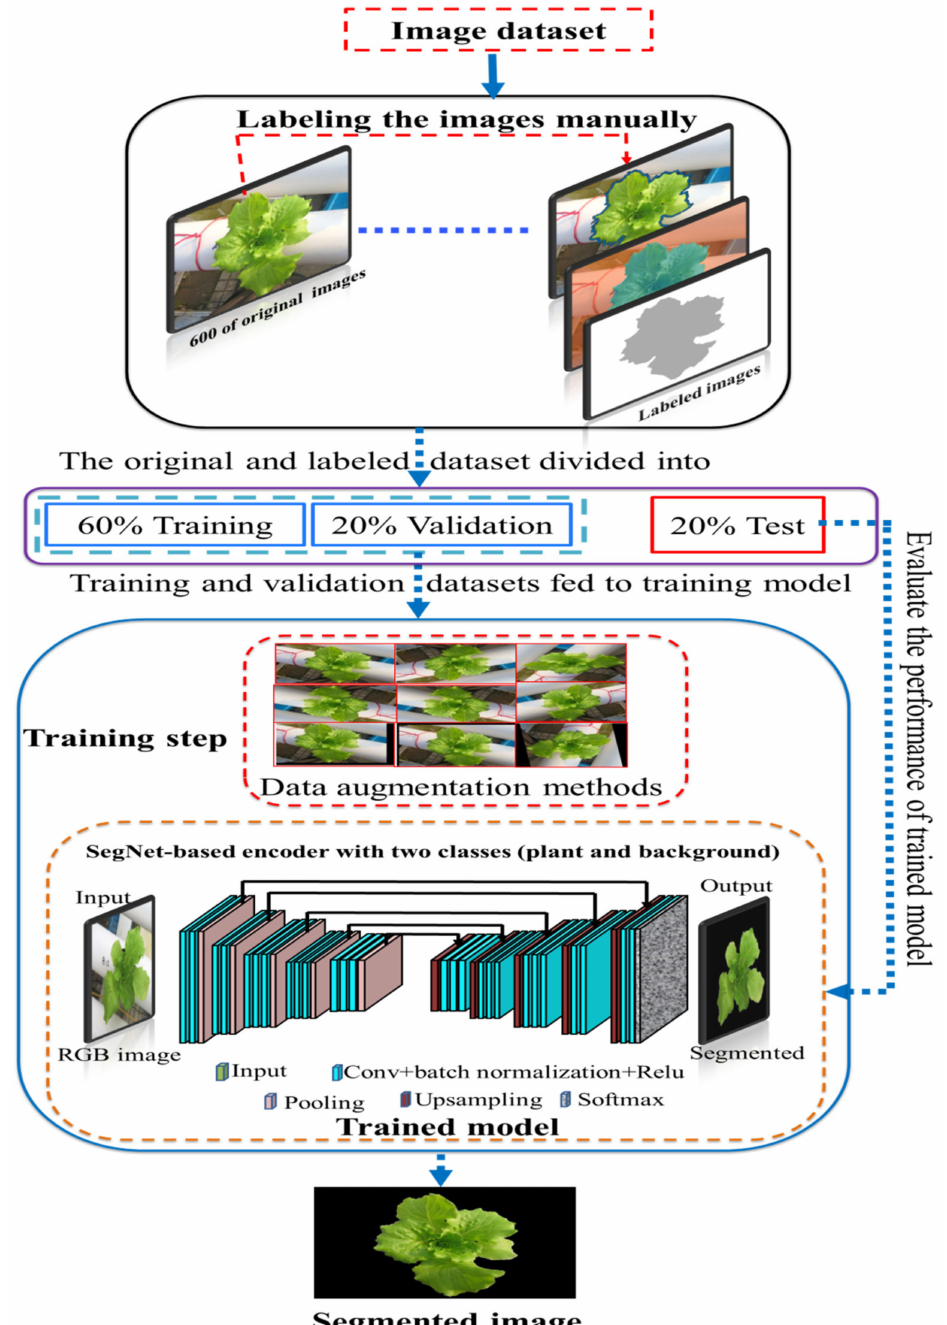
Figure 5. Flowchart of segmentation process using